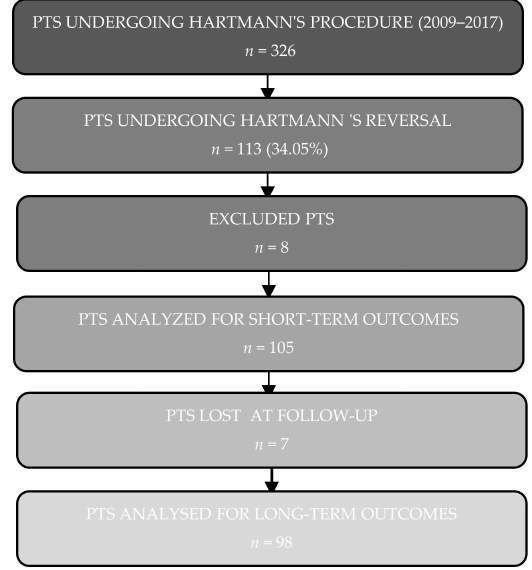
Figure 1. Flow diagram of patient recruitment.